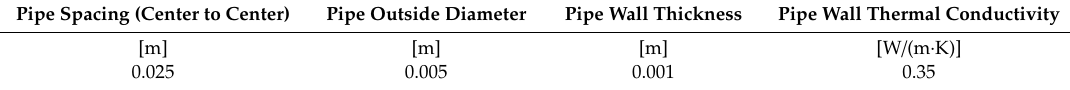
Table 1. Specifications of a radiant heating system that consists of capillary tubes.